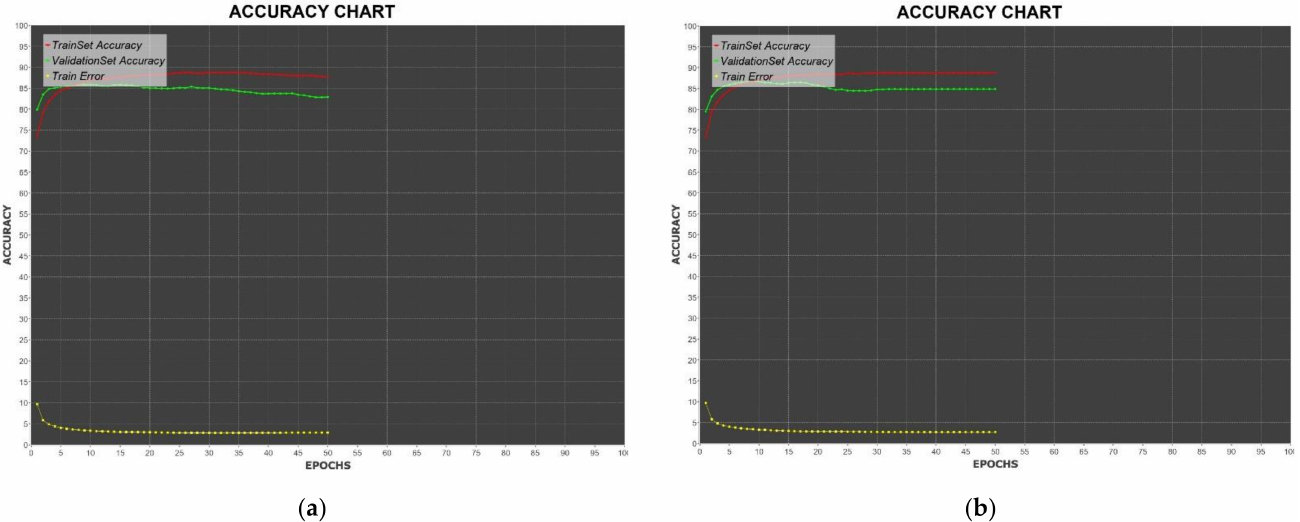
Figure 11. Comparison of fixed and adaptive learning rate training: ( a ) training with fixed learning rate 0.0005; ( b ) training with adaptive learning